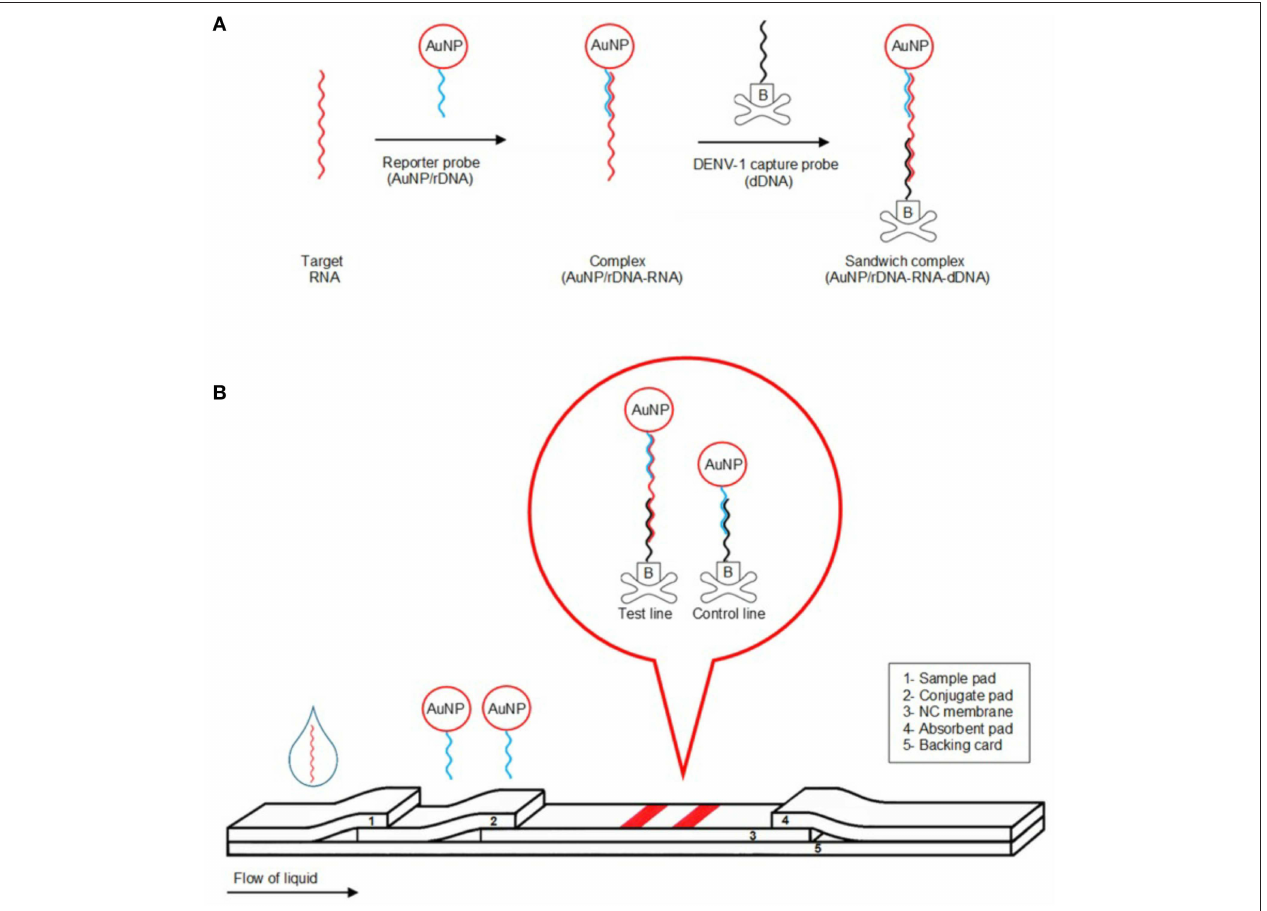
FIGURE 3 | Illustration of detection mechanism of the detection of dengue-1 RNA using dextrin-capped AuNP as label in a POC device. (A) Formation of AuNP/rDNA-RNA-dDNA sandwich complex. (B) Schematic of visual detection. Reprinted with permission from Yrad et al. (2019). Visual detection of dengue-1 RNA using gold nanoparticle-based lateral flow biosensor. Diagnostics